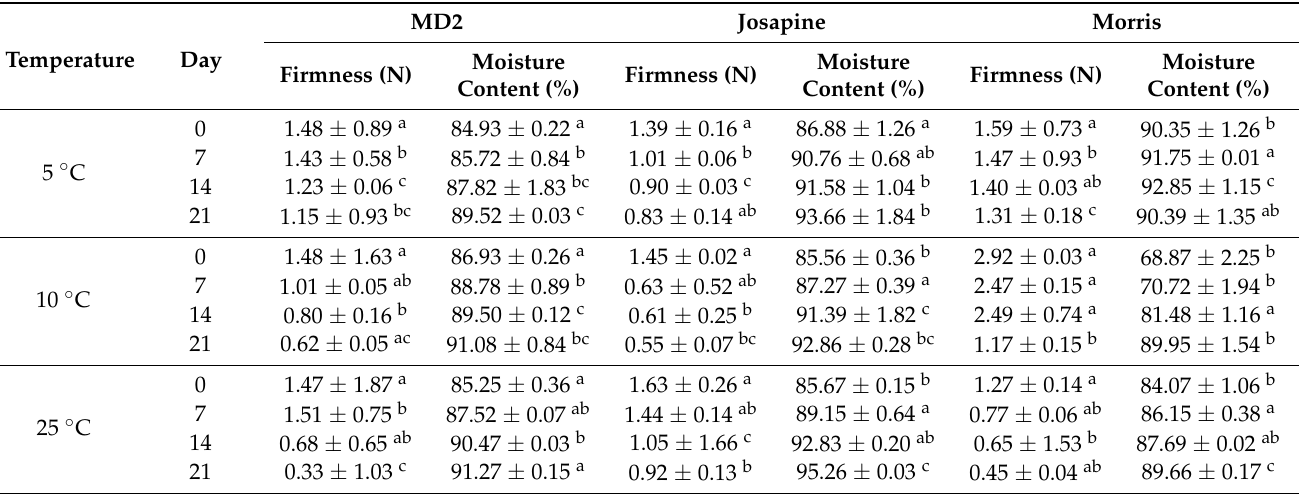
Table 2. Changes in firmness and moisture content of pineapples during storage at different storage